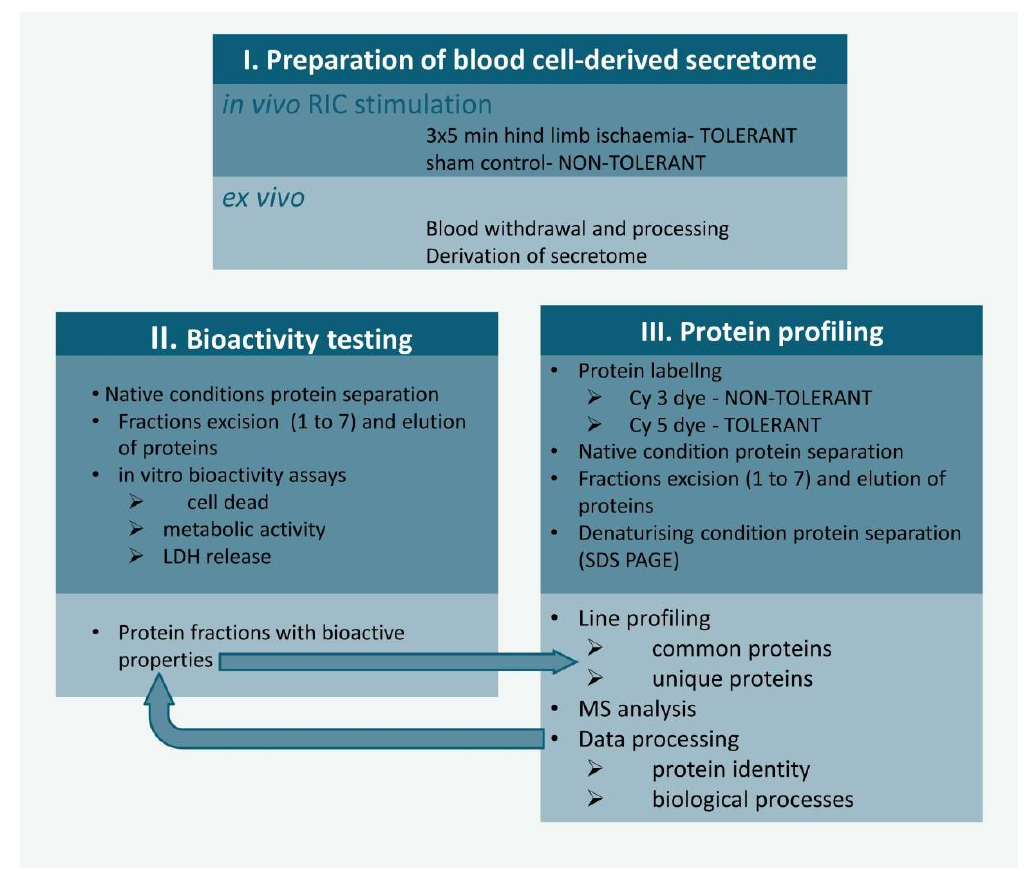
Figure 1. Experimental design. ( I ) RIC stimulation/non-stimulation of rats via limb ischaemia followed by the preparation of blood cell-derived secretomes. ( II ) Protein mixtures were separated with native polyacrylamide gel electrophoresis (PAGE) and partitioned into seven fractions. Proteins were passively eluted from the gel pieces, and the bioactivity of proteins was tested for each fraction. ( III ) Cy3- and Cy5-labelled proteins were separated into the tolerant/non-tolerant secretome with native PAGE, and then partitioned into seven fractions. Proteins were passively eluted from gel pieces. Proteins were subjected to semiquantitative analysis of uniquely secreted proteins and/or changes in common protein contents, followed by mass spectrometric (MS) analysis of proteins.